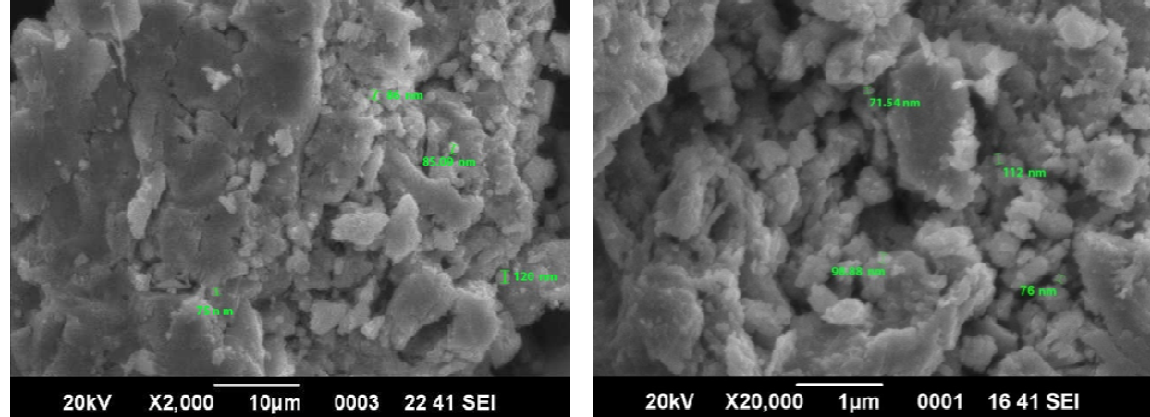
Fig. 5. Scanning electron microscopy photograph of SNPs mediated by aqueous fruiting body extract of G. applanatum